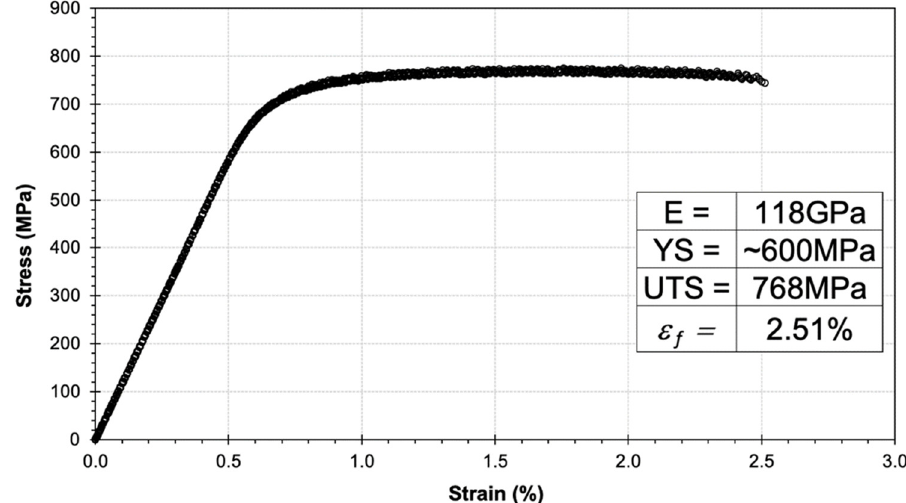
Figure 6. Stress–strain curve measured from a flat plate LG685 specimen.